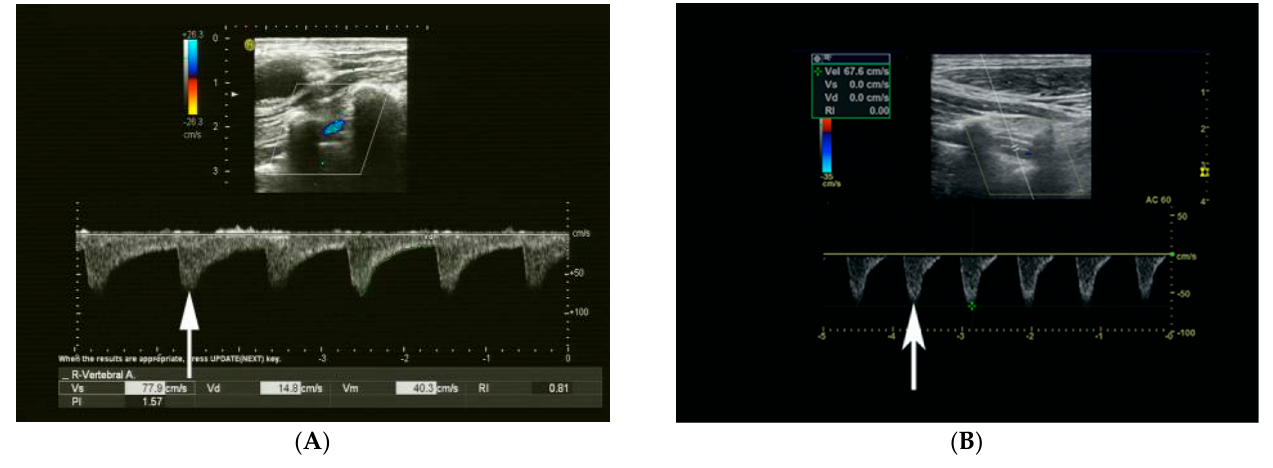
Figure 2. ( A ) A 60 − year − old man with CCRF (arrow) in the right VA on Doppler US imaging. DSA confirmed occlusion in the ipsilateral proximal SA. CCRF, continuous completely reversed flow; VA, vertebral artery; US, ultrasound; DSA, digital subtraction angiography; SA, subclavian